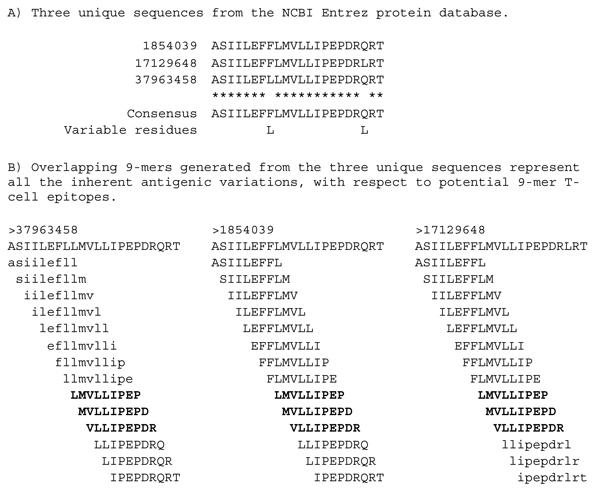
Definition of antigenically redundant sequence. A) The three sequences (NCBI GI no.: 1854039, 17129648 and 37963458) are each unique, and residues that vary among them are shown. B) Overlapping 9-mers generated from the three unique sequences represent all the inherent antigenic variations, with respect to potential 9-mer T-cell epitopes. Although the three sequences are each unique, they share identical 9-mers. 9-mers shown in uppercase are those with an identical match in two of the unique sequences analyzed, while those in bold uppercase have an identical match in all three sequences; unique 9-mers are shown in lowercase. All the 9-mers in sequence 1854039 have a match in at least one of the other two sequences; thus, the antigenic diversity of this sequence can be covered by the other two sequences combined, rendering the sequence 1854039 antigenically redundant. Hence, the minimal number of sequences required to represent antigenic diversity for this dataset is two.